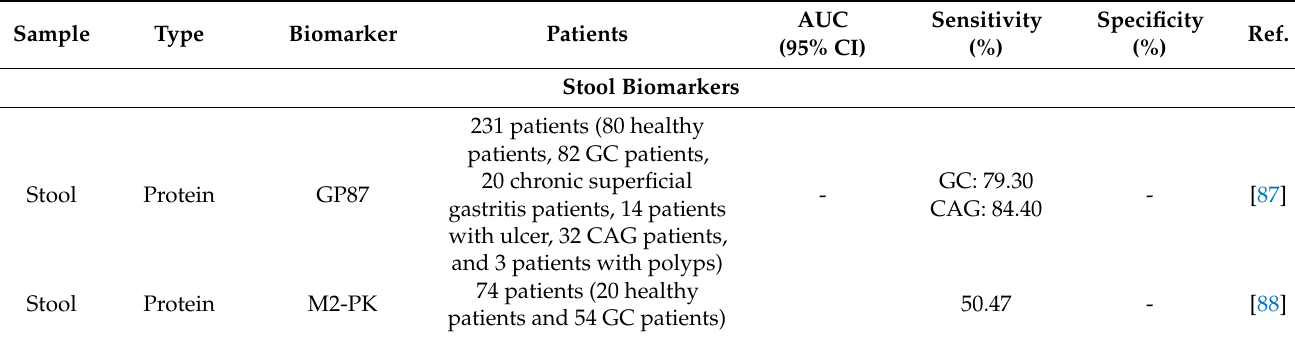
Table 4. Summary of potential fecal biomarkers for gastric cancer screening and early